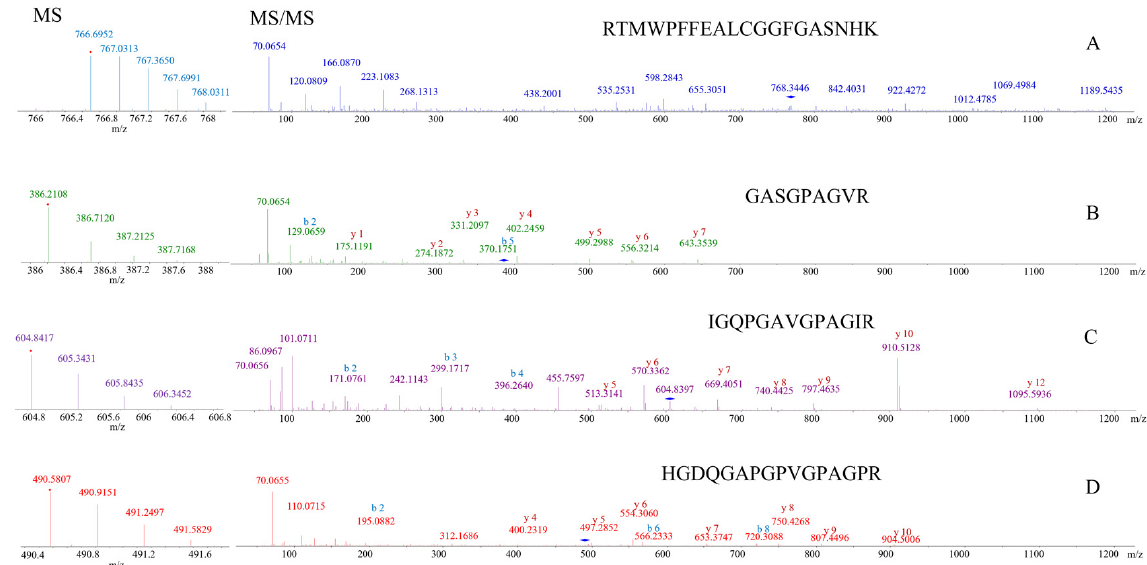
Figure 5. MS and MS/MS spectra of representative high-sensitivity marker for each animal species, including ( A ) donkey-specific marker 4, ( B ) horse-specific marker 1, ( C ) cattle-specific marker 2 and ( D ) pig-specific marker 2. Peptide sequences of ( B – D ) are obtained by searching protein databases. By comparing with Skyline software, their matched b and y ions are indicated. Table 4. The precursor ion, retention time, product ion, and collision energy of the selected species- specific markers.